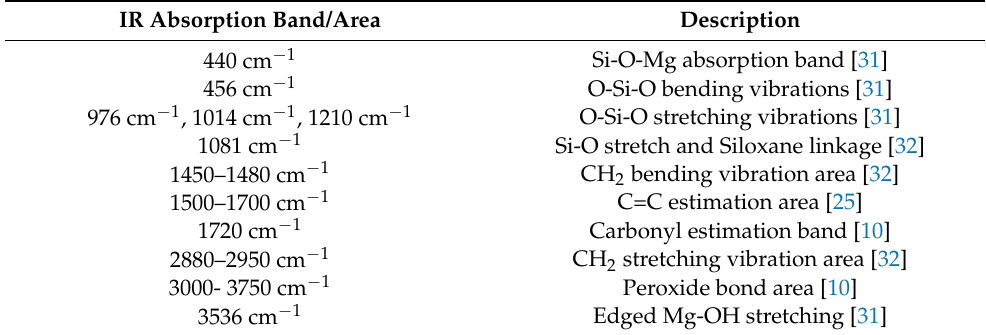
Table 3. Infrared absorption bands of interest.